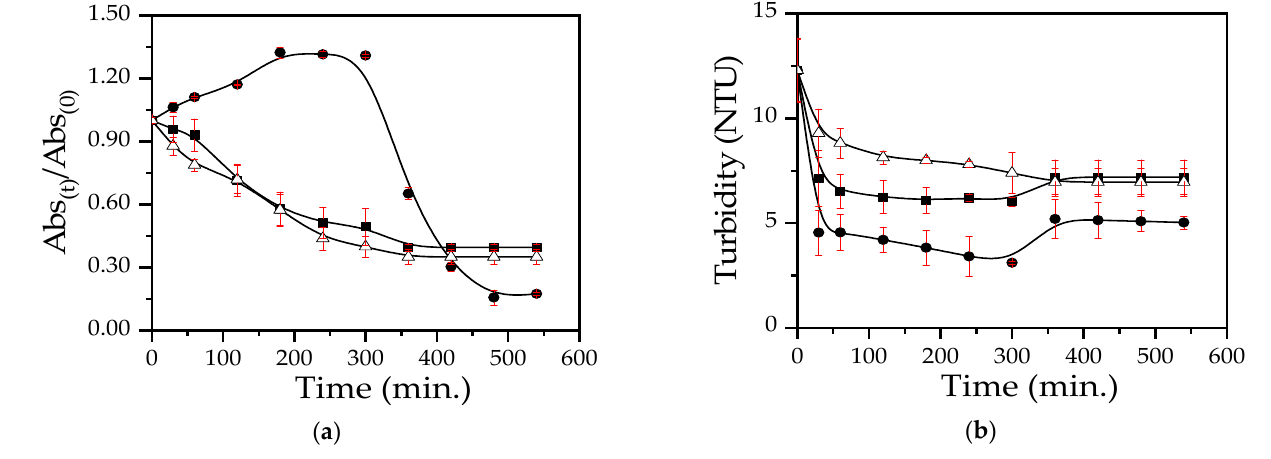
Figure 4. ( a ) Evolution of normalized absorbance at 254 nm and ( b ) turbidity decay of winery wastewater during electrolysis without the addition of electrolyte support at 25 °C and pH 4.28 applying 30 mA/cm 2 . ( ■ ) MMO-Cl 2 , ( ∆ ) MMO-O 2 , ( ● ) BDD. Samples tested: 11.